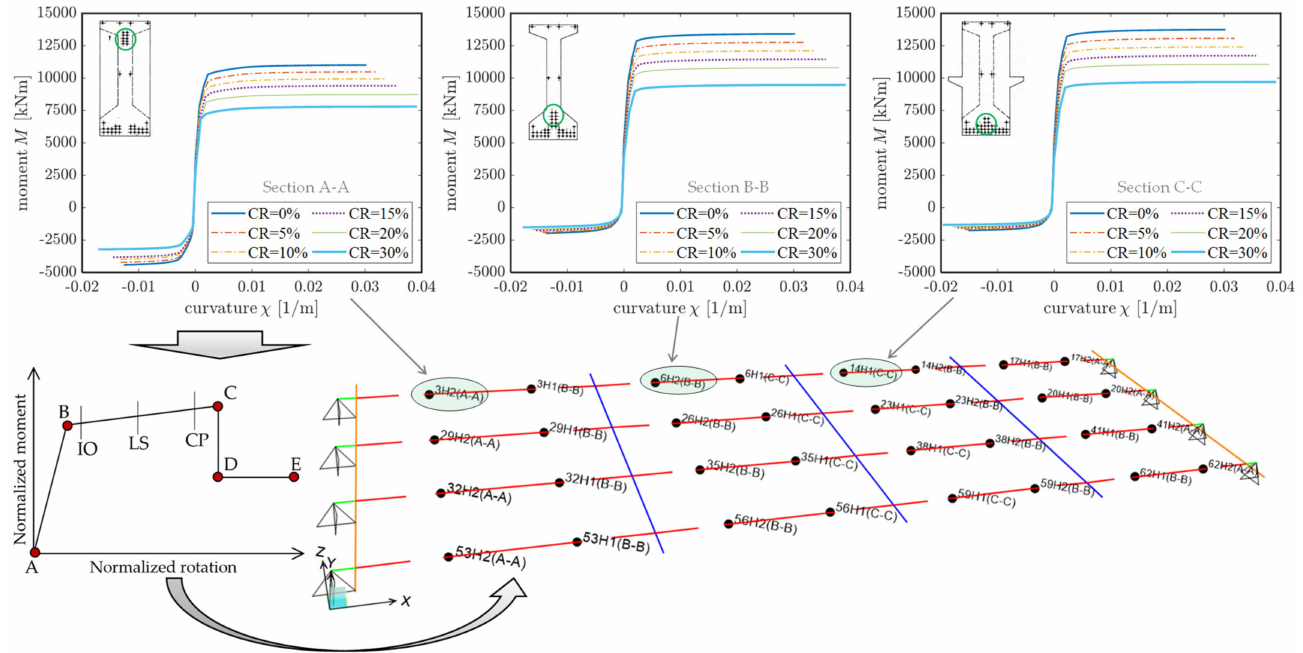
Figure 18. FE model of the corroded bridge deck with material nonlinearity simulated through a set of plastic hinges in longitudinal girders (concentrated plasticity approach) with properly calibrated moment-curvature relationships.